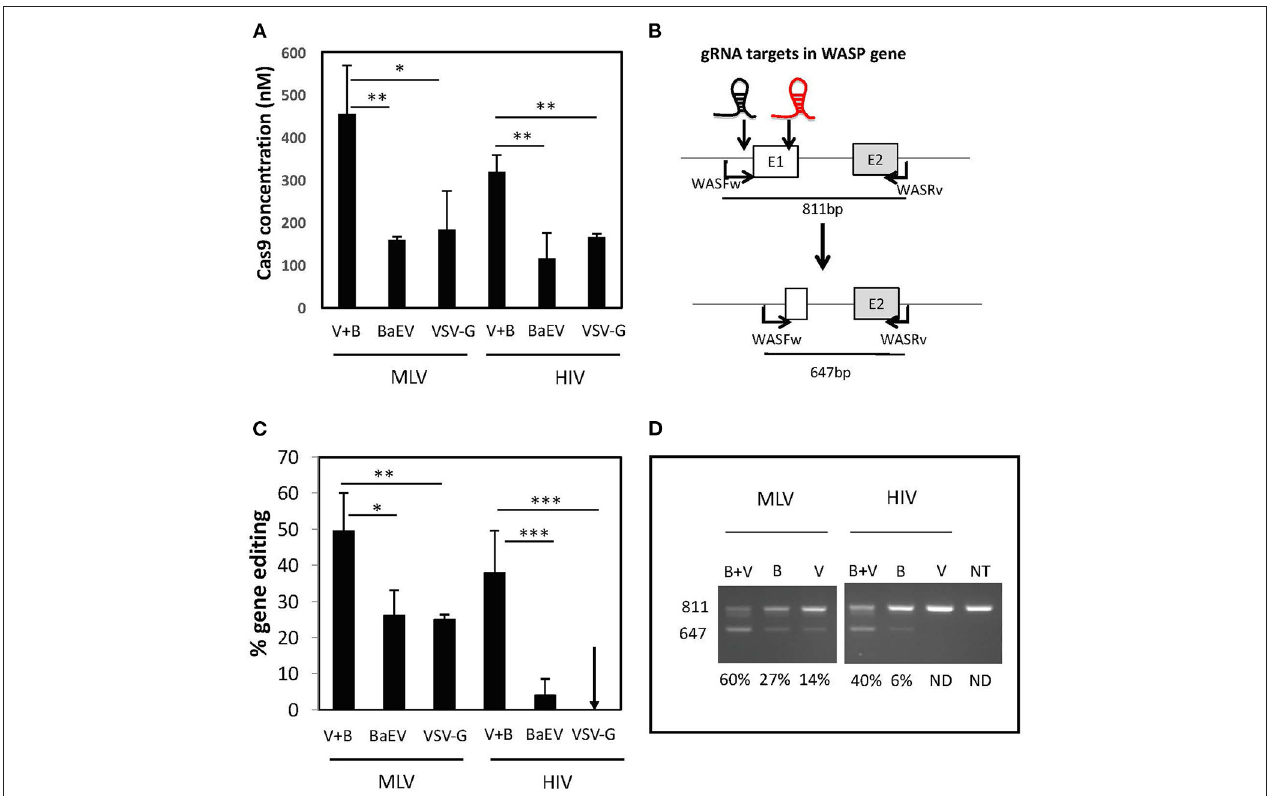
FIGURE 2 | BaEV/VSV-G gp pseudotyped nanoblade-mediated gene editing in cell lines. (A) Concentration of Cas9 in nM present in the nanoblades measured by ELISA in MLV and HIV-derived nanoblades co-pseudotyped with BaEV- and VSVG-gps (B + V) or pseudotyped only with BAEV-gp or VSVG-gp (V) (means ± SD, n = 3; student t -test, * p < 0.05 and ** p < 0.01) (B) Schematic representation of expected band sizes of WAS PCR product with WASFw/WASRv primers before the cleavage (811 bp), which represent the intact WAS gene and the edited WAS gene after the deletion upon DSB at both gRNA targets (647 bp); the gRNA-301 and − 305 target sites are indicated as a black and red gRNA, respectively; (C) Graph summarizing percentage of cleavage (right) (means ± SD; MLV B + V n = 17, MVL B n = 4, MLV V n = 5, HIV B + V n = 16, HIV B n = 7, HIV V n = 6; student t -test, * p < 0.05, ** p < 0.01, and *** p < 0.001). (D) Representative electrophoresis gel of the PCR products on genomic DNA from 293T cells transduced with MLV or HIV nanoblades co-pseudotyped with B + V, B, or V gps; quantification of gene editing is indicated for each lane